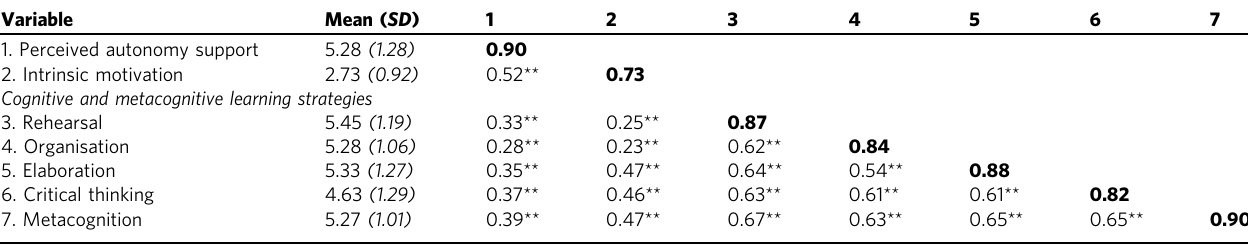
Table 3 Means and standard deviations, correlations between measured variables, and reliability coef fi cients for each subscale.